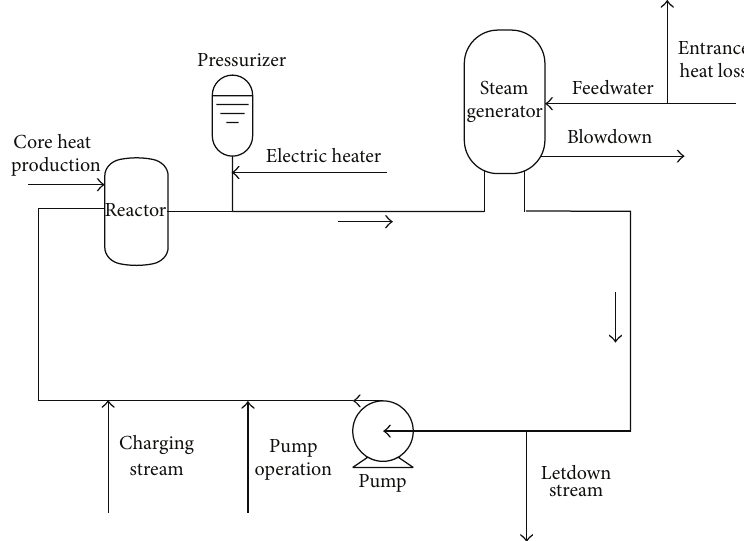
Figure 6: Heat balance principle diagram of double-loop